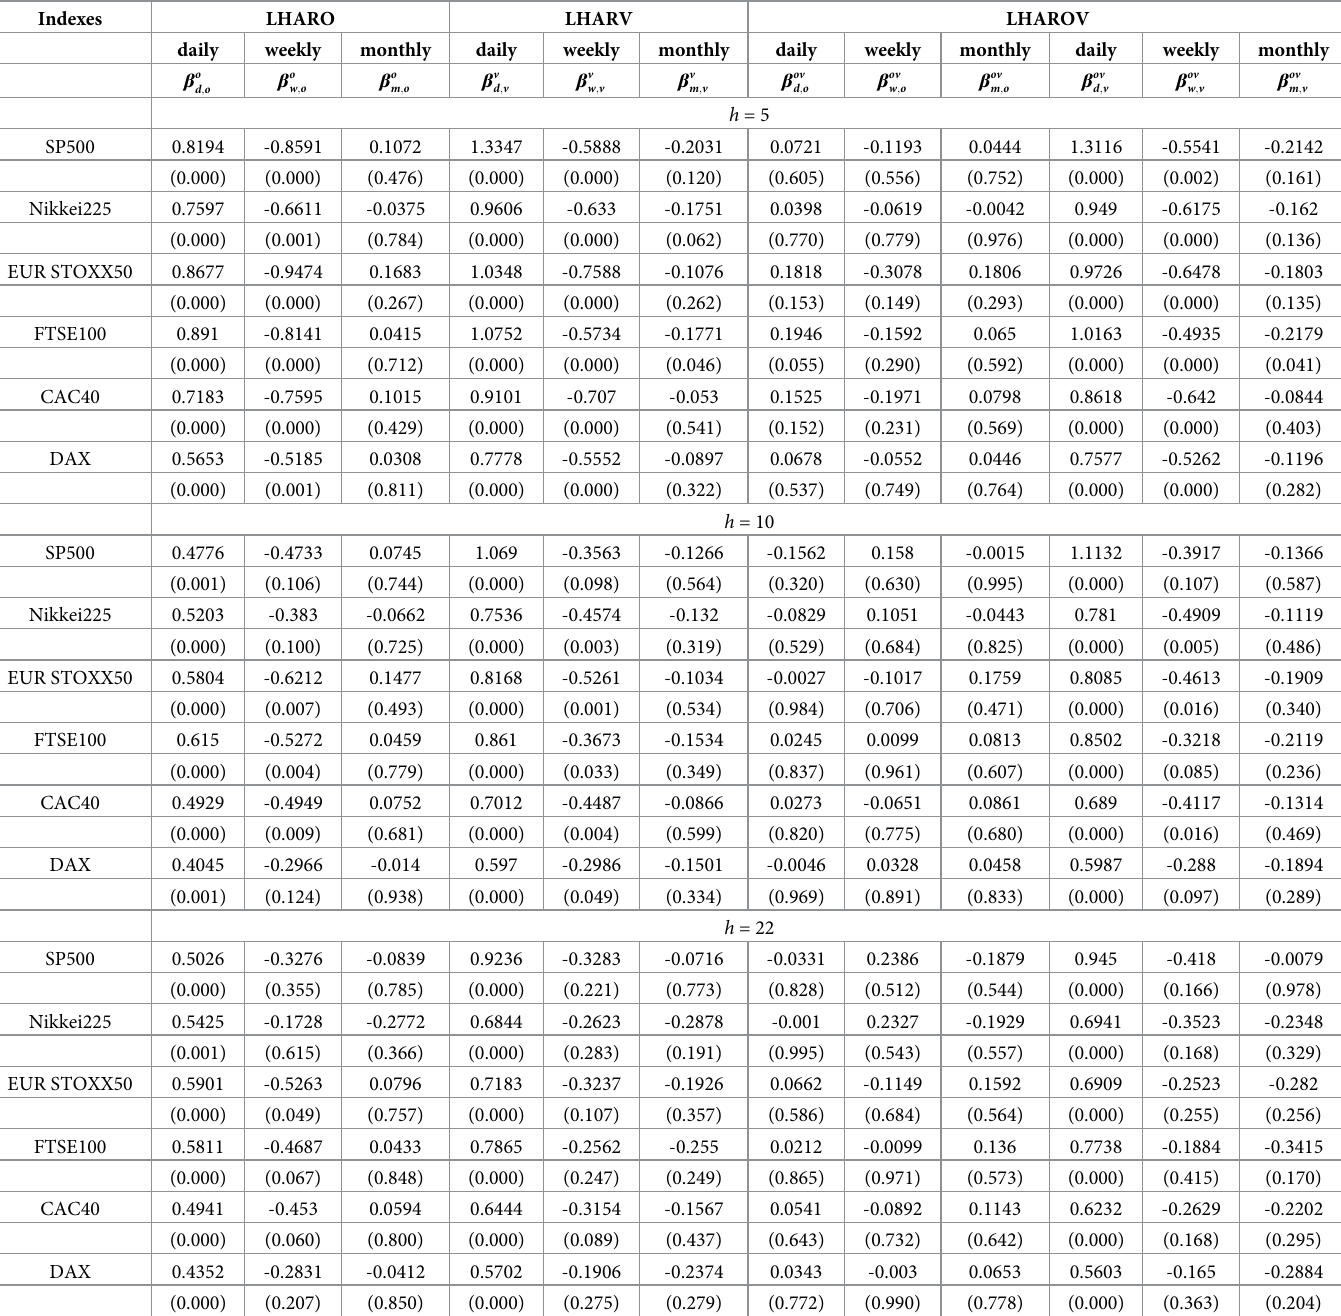
Table 5. Full sample estimations of LHARO, LHARV and LHAROV (long forecasting